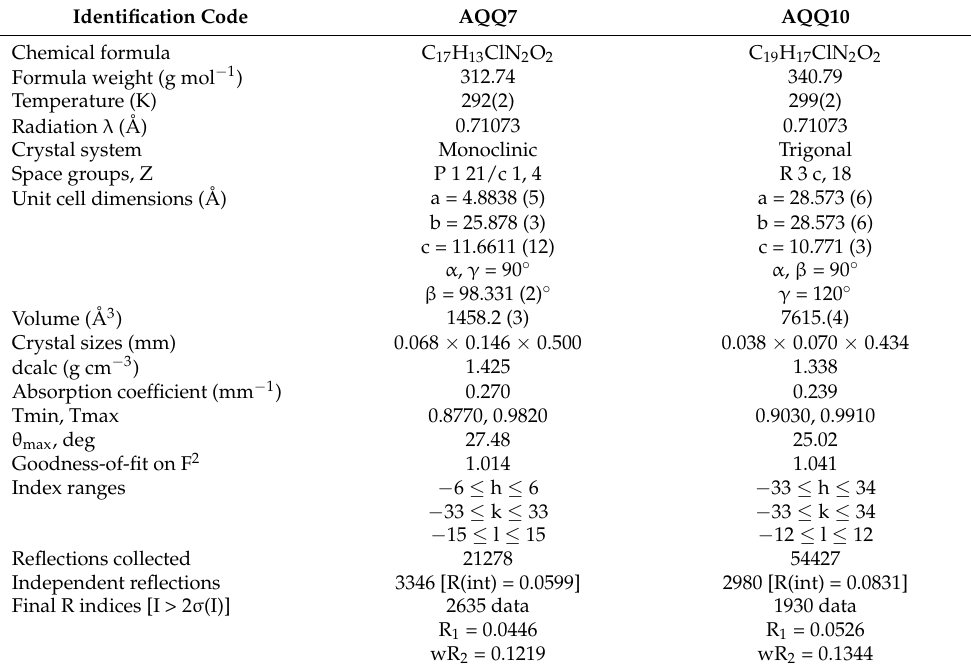
Table 1. Crystallographic data for the AQQ7 and AQQ10